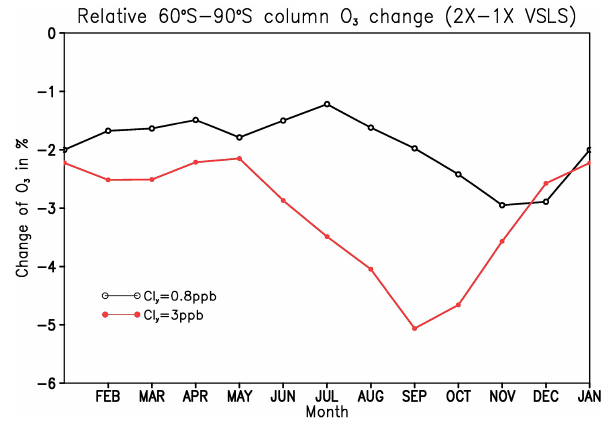
Figure 3. Relative change in column ozone (in %) due to a doubling of VSLS Br y averaged over 60–90 ◦ S. Each line represents one par- ticular Cl y level (black open circles: Cl y = 0.8ppb; red closed cir- cles: Cl y = 3ppb). Note that we average the ozone difference over the three different Br y concentrations for each Cl y case. The in- dividual results for different background Br y are shown in Figs. 1 and